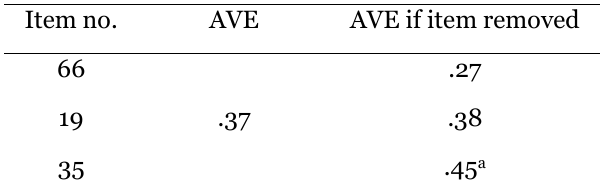
AVE Reliability for Factor 10